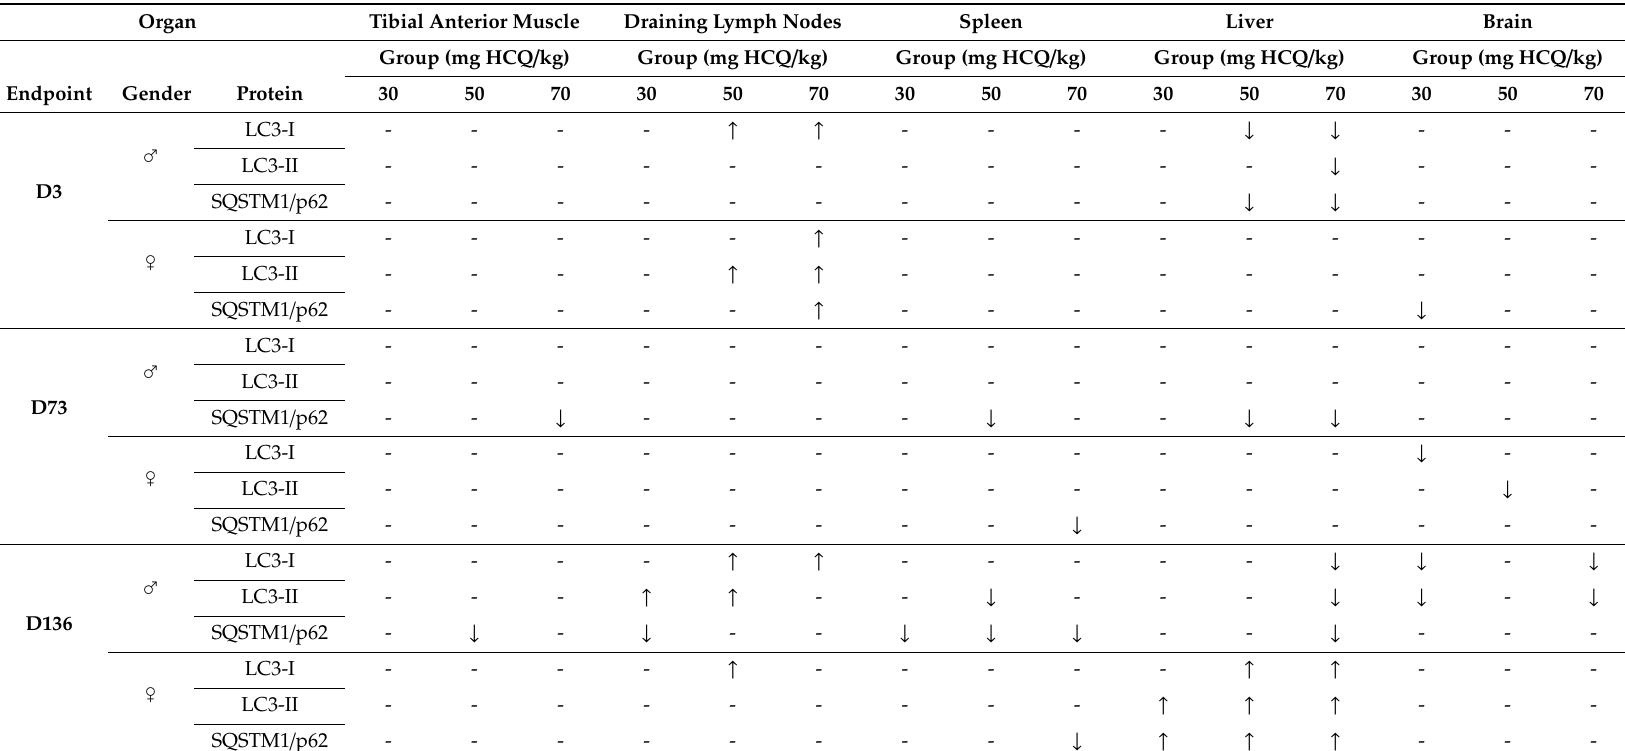
Table 3. E ff ects of HCQ treatment on LC3 and SQSTM1 / p62 proteins tissular level at several endpoints of the adult